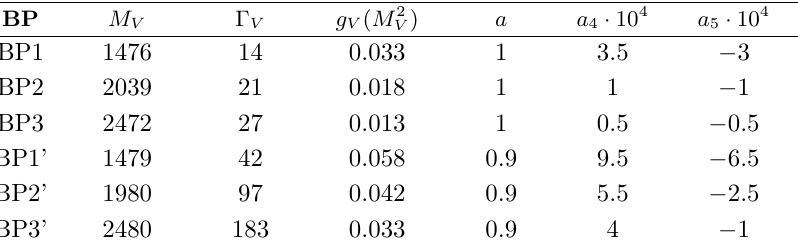
Table 1 . Selected benchmark points (BPs) of dynamically generated vector resonances taken from [29]. The mass, M V , in GeV; width, (cid:0) V , in GeV; and coupling to gauge bosons, g V ( M 2 well as the relevant chiral parameters, a , a we have set b = a 2